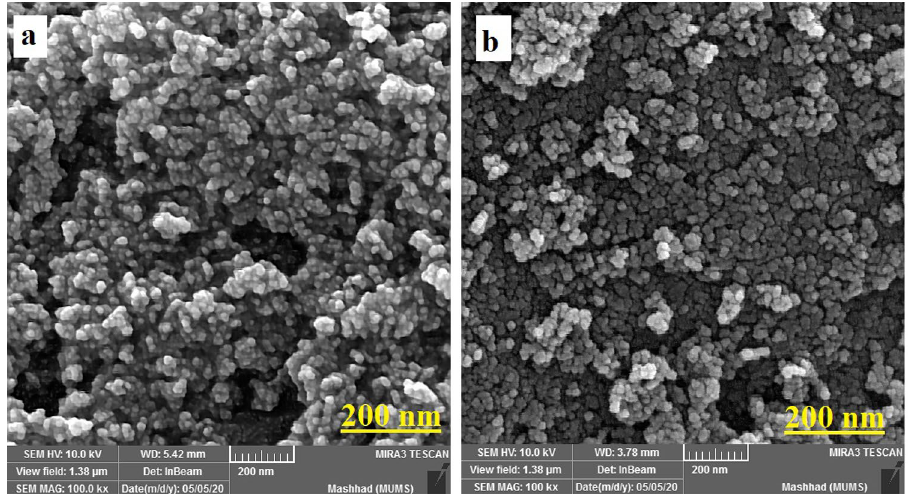
Fig. 3 FESEM images of γ -Al 2 O 3 NPs a before adsorp- tion and b after